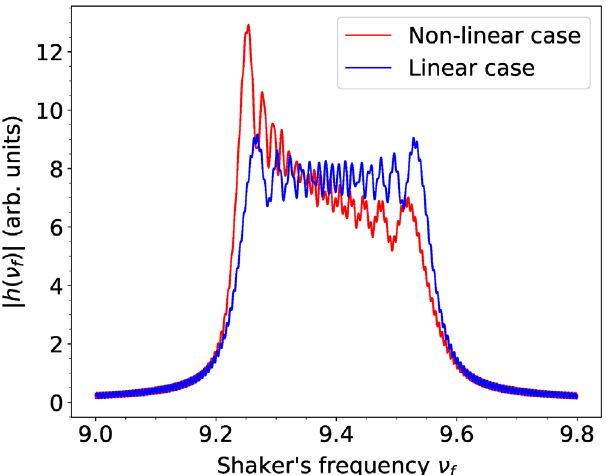
FIG. 8. Comparison of the frequency responses for the range from the 215th to 400th turn with and without the nonlinear chromatic effects. Red and blue curves represent the nonlinear and linear cases, respectively. The machine parameters for the nonlinear case are the same as those of Sec. III, whereas the calculation for the linear case uses the averaged chromaticity parameters (see the text